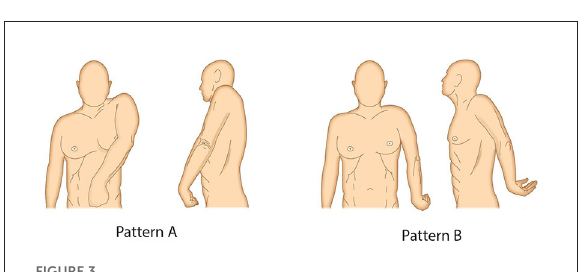
FIGURE3 Two most common shoulder spasticity patterns. (A) Adduction, elevation, flexion and internal rotation of shoulder. (B) Abduction or adduction, extension and internal rotation of